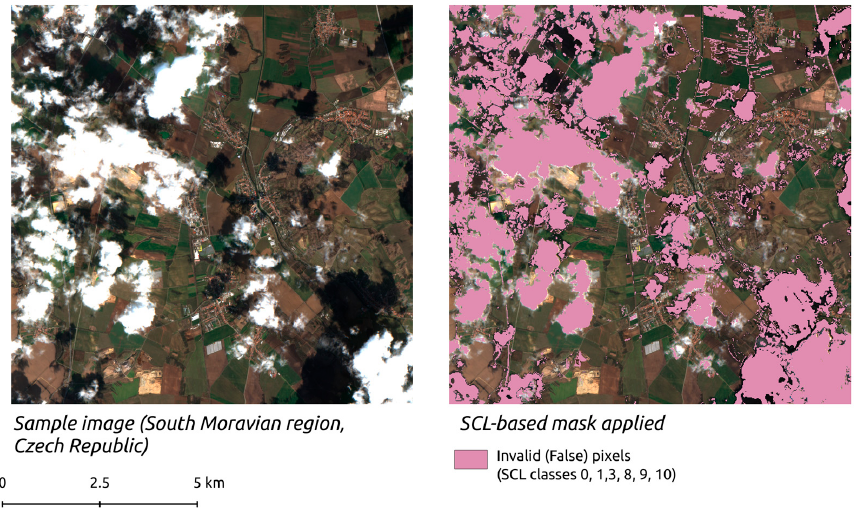
Figure 2. Sample scene classification layer (SCL)-based mask applied on a Sentinel-2 image. Data source: Sentinel-2 image from 14.3.2019.